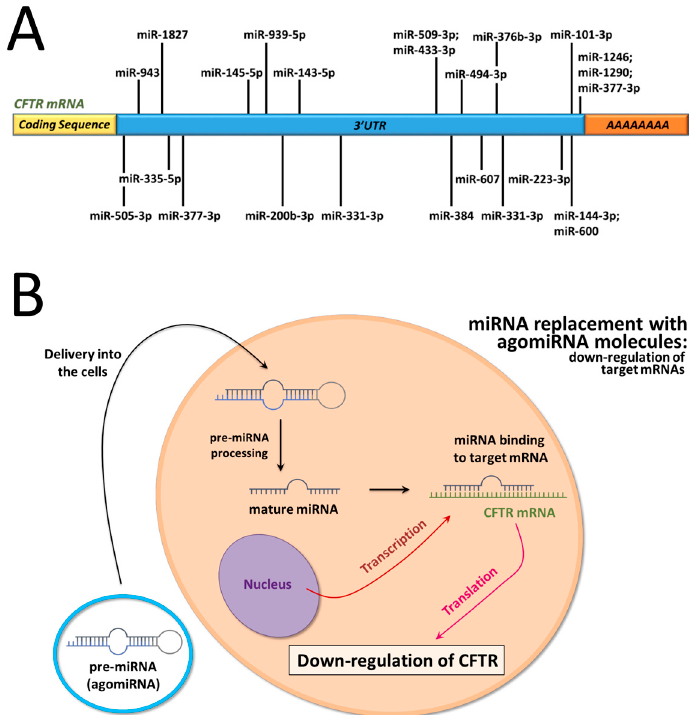
Figure 1. ( A ). Location of miRNA binding sites within the 3 ′ UTR of the CFTR mRNA. ( B ). Scheme depicting the miRNA replacement approach using transfected agomiRNAs (see panel A ) to downregulate CFTR gene expression. Adapted with permission from Papi et al. [27]; (copyright can be found at https://www.mdpi.com/1422-0067/23/16/9348 (2022, by Papi et al.) [27]. AgomiR molecules mimicking the activity of the CFTR regulatory miRNAs are, on the contrary, expected to downregulate CFTR